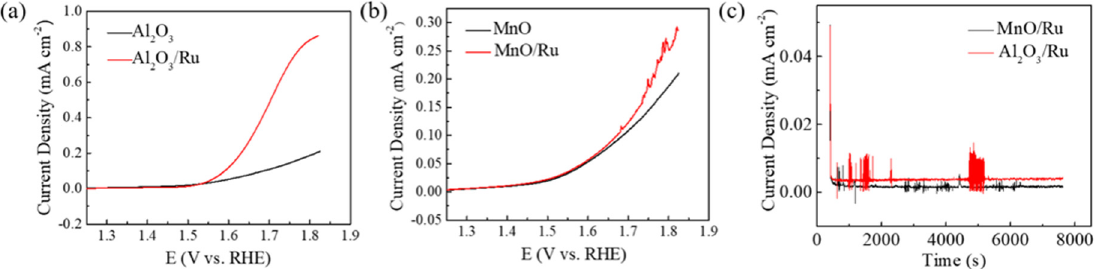
Figure 4. ( a ) LSV curves of δ − Al 2 O 3 and δ − Al 2 O 3 /Ru. ( b ) LSV curves of MnO and MnO/Ru. ( c ) Chronoamperometry (CA) curve of δ− Al 2 O 3 /Ru and MnO/Ru.